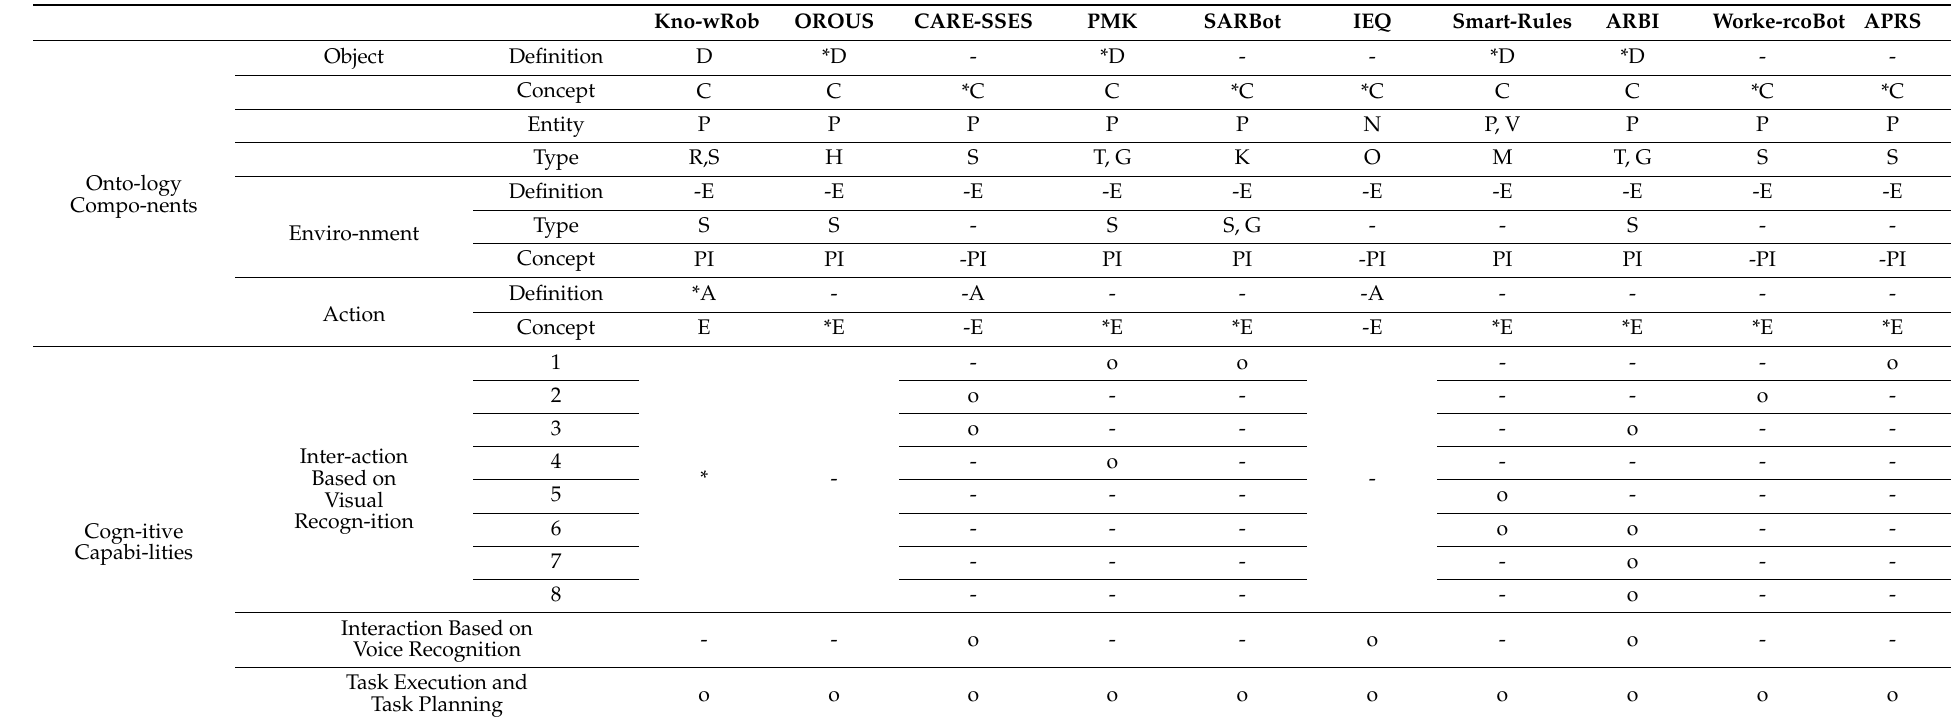
Table 8. Summary of the evaluation results for ontological components and cognitive